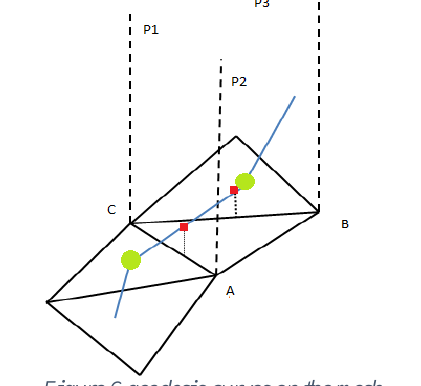
Figure 6 geodesic curves on the mesh